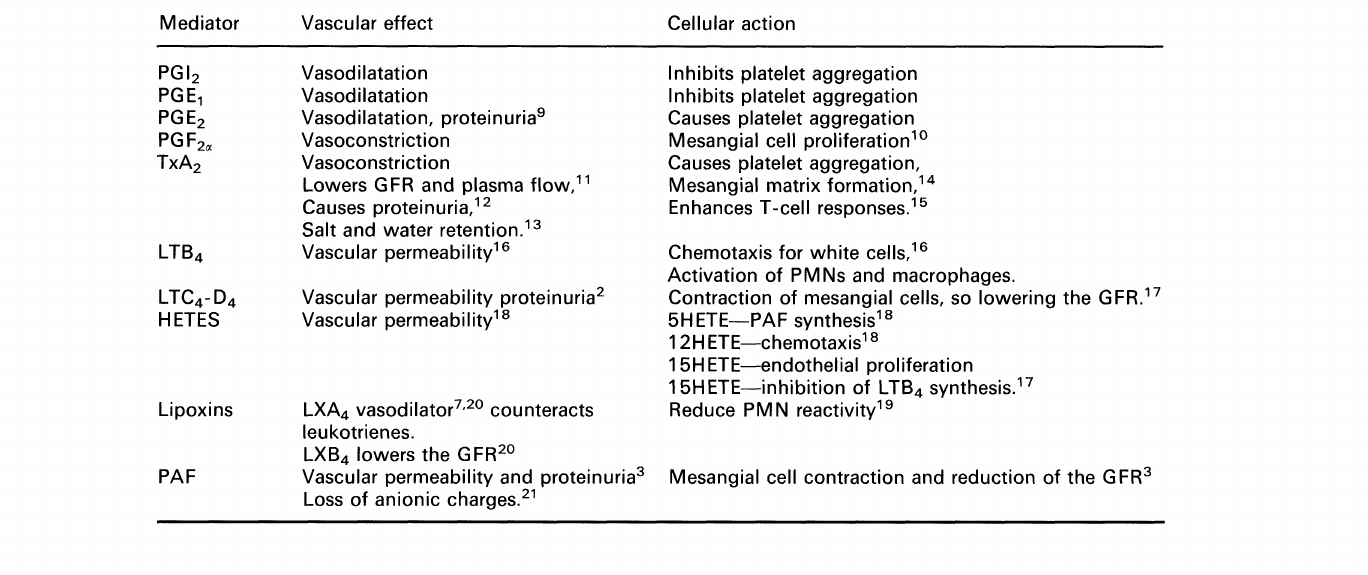
Table 1. Pharmacological actions of phospholipid-derived mediators